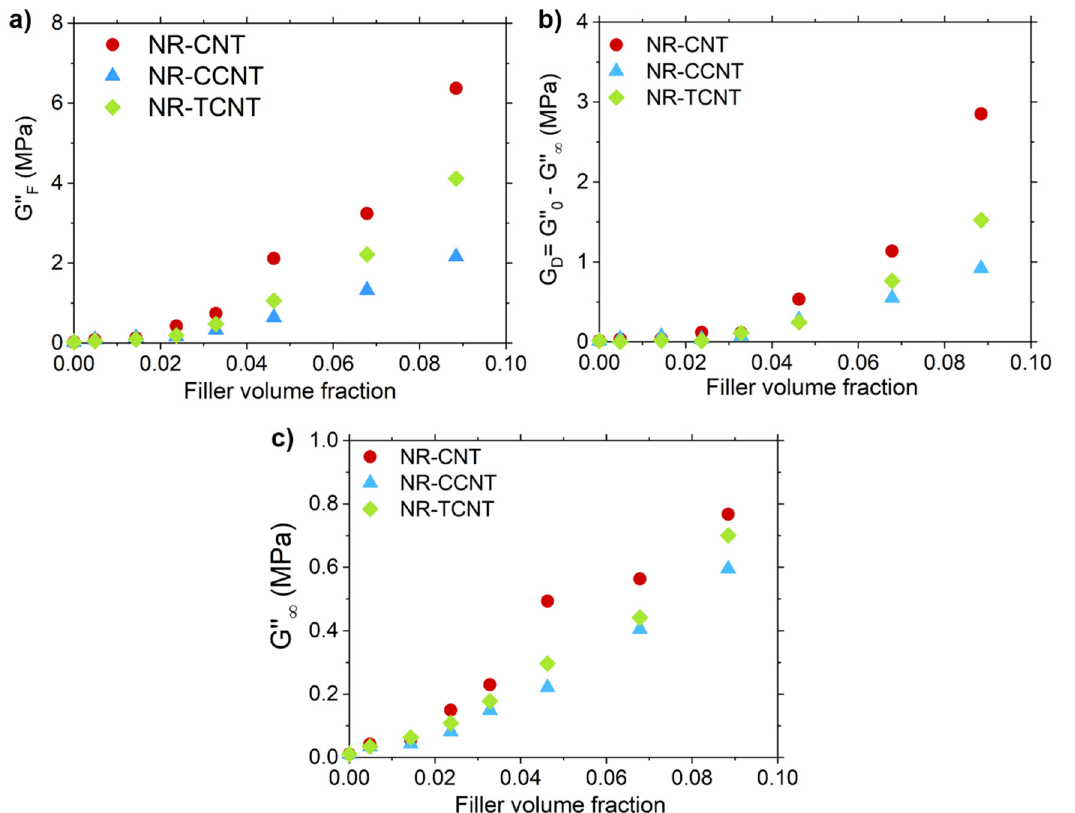
Figure 16. Variation of 𝐺 (cid:3005)(cid:4593)(cid:4593) , 𝐺 (cid:3007)(cid:4593)(cid:4593) , and 𝐺 (cid:2998)(cid:4593)(cid:4593) with the increasing filler for the studied compounds ( a – c ). Aligned with these results, the difference between the loss moduli measured at the minimum and maximum strain ( 𝐺 (cid:3005)(cid:4593)(cid:4593) = 𝐺 (cid:2868)(cid:4593)(cid:4593) − 𝐺 (cid:2998)(cid:4593)(cid:4593) (cid:4667) , which is related with the dissipation of energy associated with the filler–rubber–filler interactions, rises with the filler volume